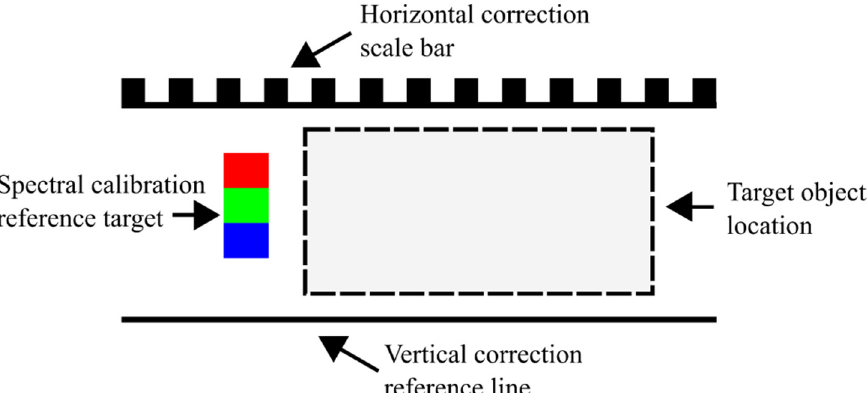
Figure 4. The calibration card. The subject of the imaging (the measurand) was placed in the target object location. The horizontal correct scale bar, spectral calibration refence target and vertical correction refence line were then used as in-scene references for spectral calibration and spatial correction.